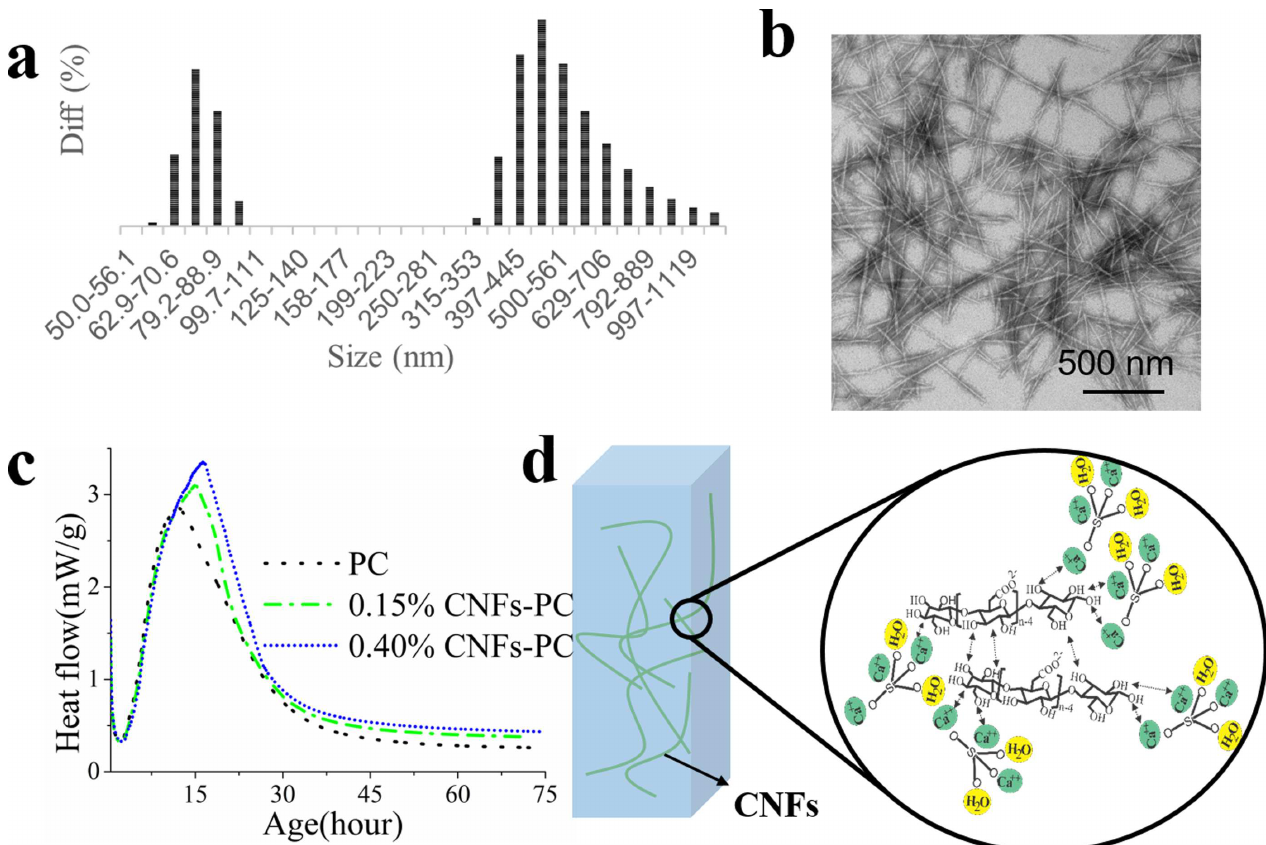
Fig 2. The morphology of cellulose nanofibers and the effect of CNFs on early hydration of cement particles. (a) Size distribution of CNFs; (b) TEM image of CNFs; (c) Heat flow curves of CNF-cement pastes for the first 72 hrs’ hydration; (d) Scheme of CNFs promotingthe setting of the cement paste by coordination with Ca 2+